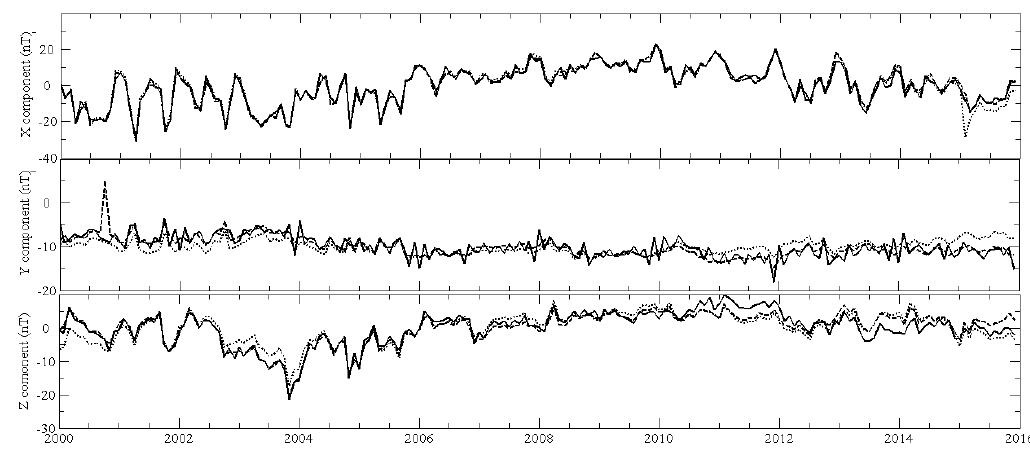
Figure 11. The external contribution to the HER observatory, calculated as shown in the text for three models: POMME-9 (solid line), EMM2015 (dashed line) and CM5 (dotted line).